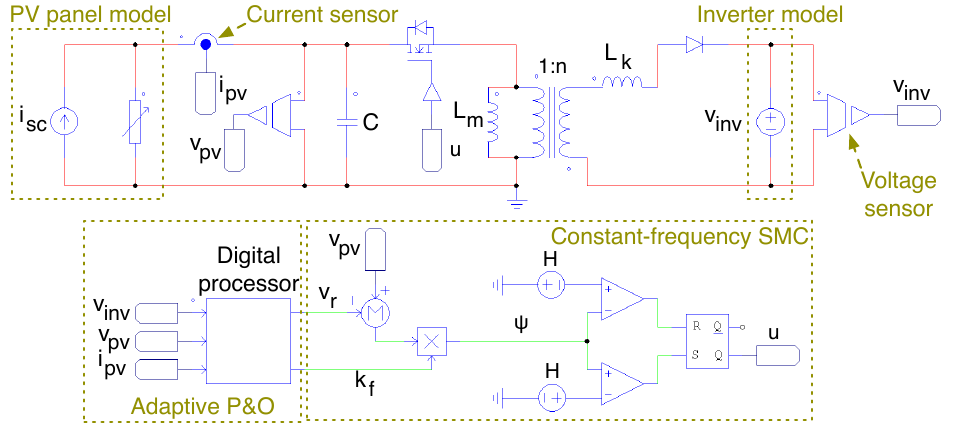
Figure 11. PV system and controller implemented in